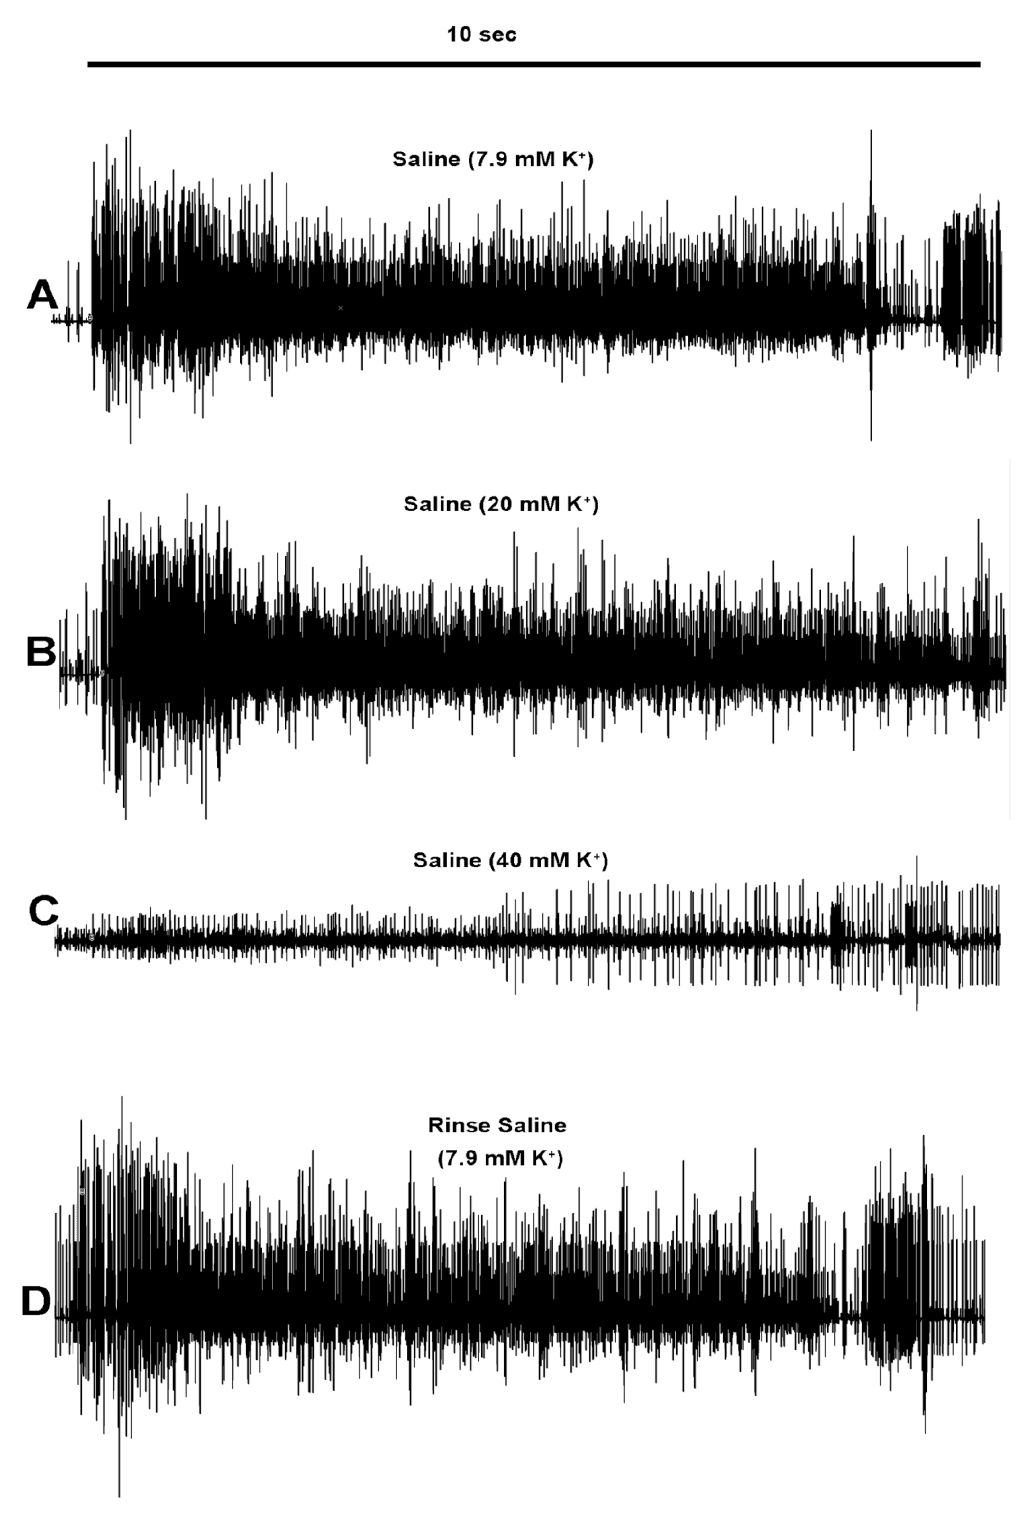
Figure 6. The effect of raised extracellular K + on the neural activity for a representative PD organ. The activity of the PD nerve over 10 s when the joint from a 90-degree angle is fully extended within 1 sec and held for 9 s. The activity in saline ( A ) to saline containing 20 mM K + ( B ). The 20 mM K + did not show a significant change in overall activity. A change to a saline with 40 mM K + ( C ) decreased the activity substantially. Some activity is regained with bathing the preparation in fresh saline ( D